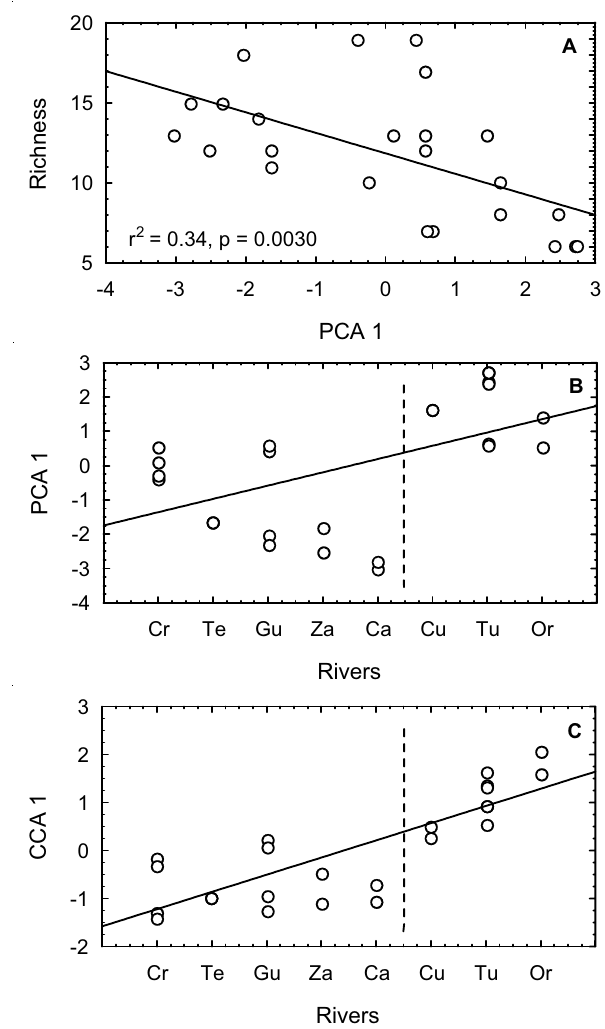
Fig. 5. Relationships between the PCA 1 and CCA 1 axes with the species richness and rivers stations. The richness (A) was moderately explained, but the multivariate (B) and canonical (C) analyses showed functional relationships with the geographical location of the